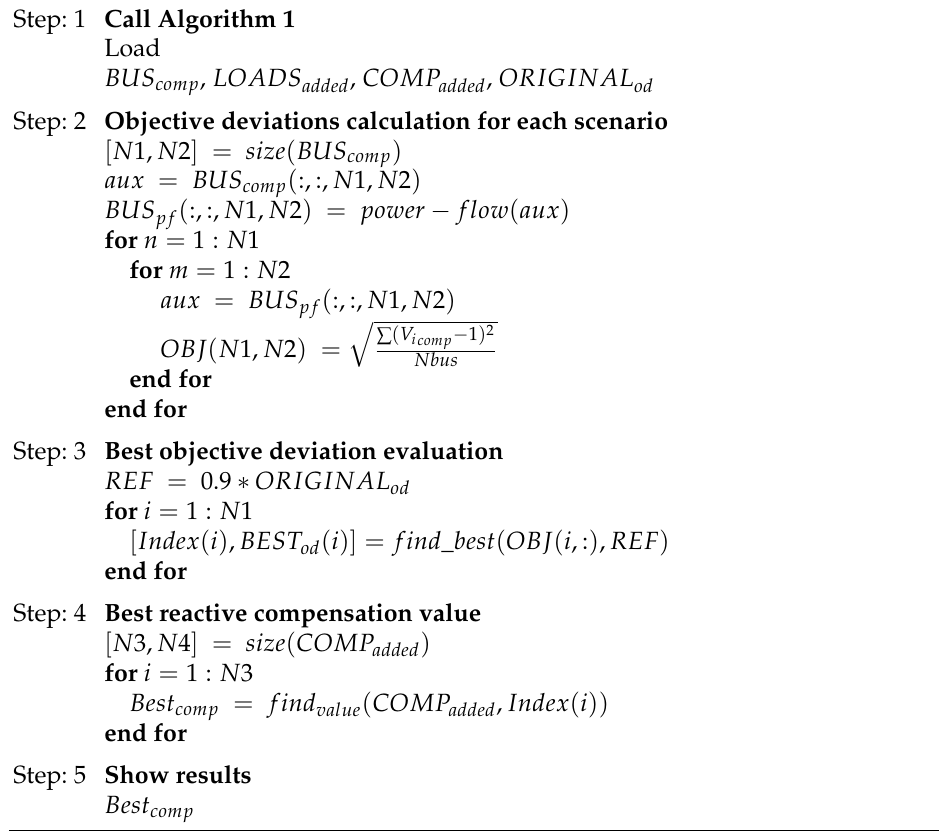
Algorithm 2 Brute force algorithm: best compensation location and